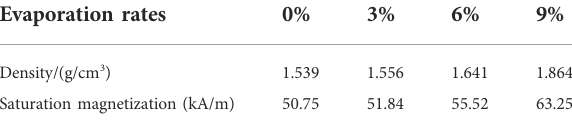
TABLE 1 Injection amount of kerosene-based magnetic fl uid with different evaporation rates.